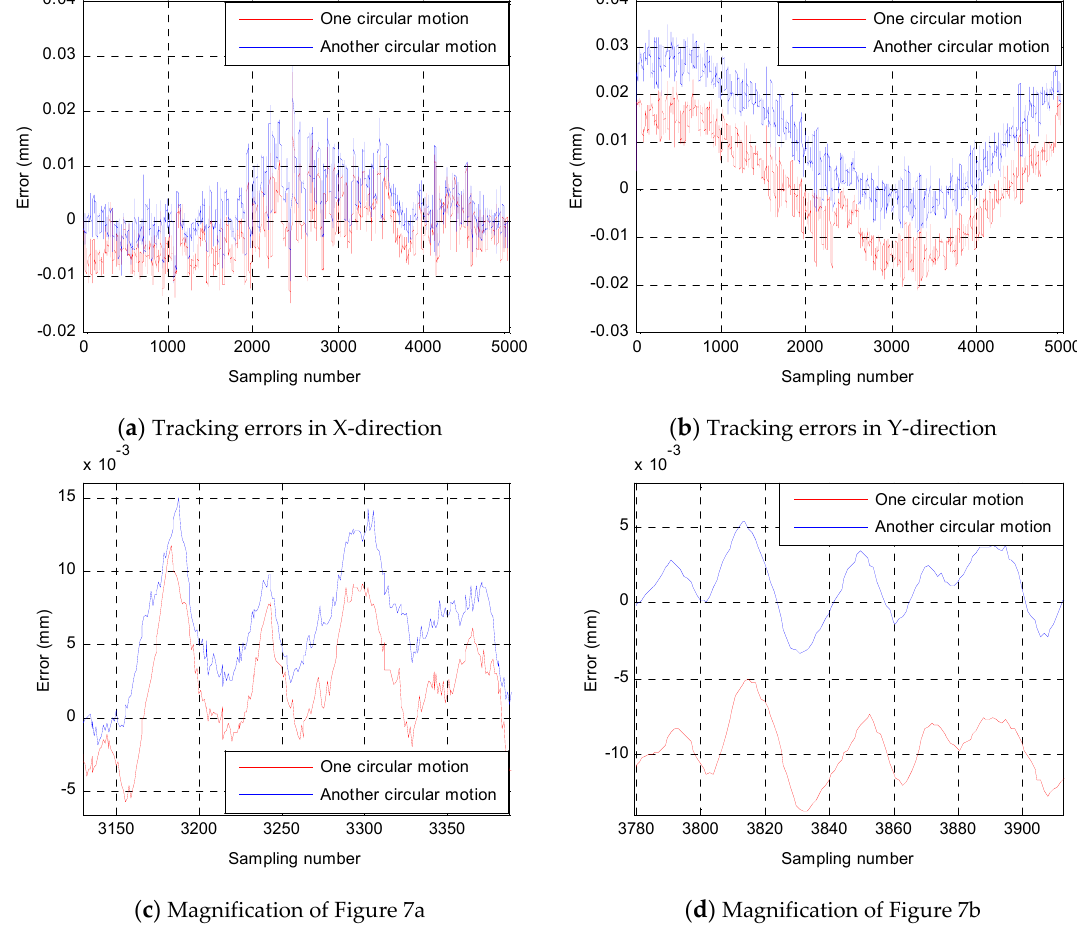
Figure 7. Semi-closed-loop tracking errors of two open-loop circular motions.